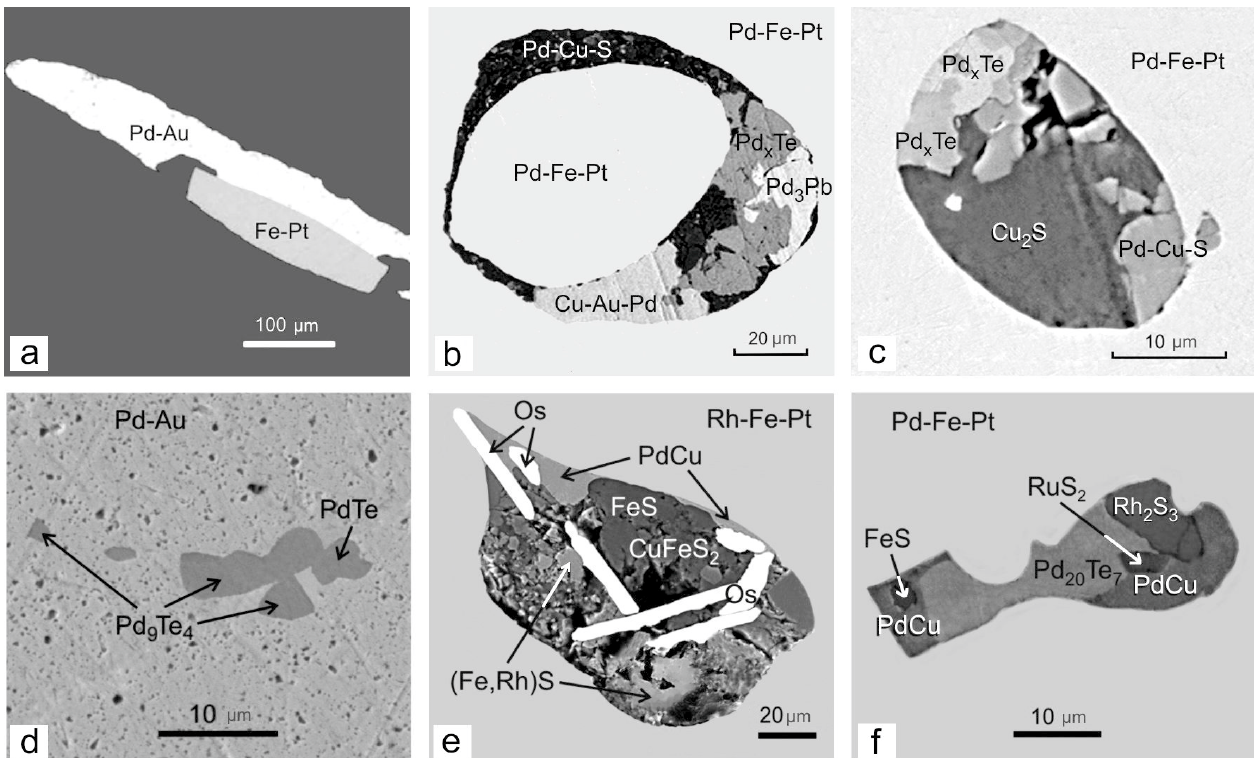
Figure 4. Forms of intergrowths of ferroan platinum and porpezite with inclusions of PGM-containing minerals from the Anabar river placers: ( a ) intergrowth of porpezite (Pd–Au) and ferroan